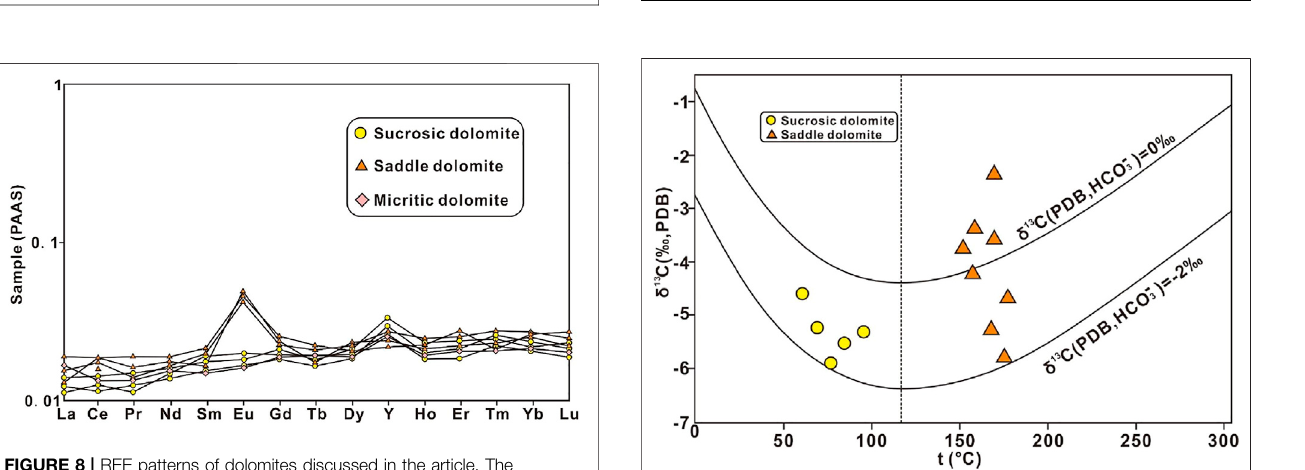
FIGURE 7 | δ 18 O and δ 13 C values display negative excursions with increasing crystal sizes from micritic to fi ne-/medium-sized dolomite samples.